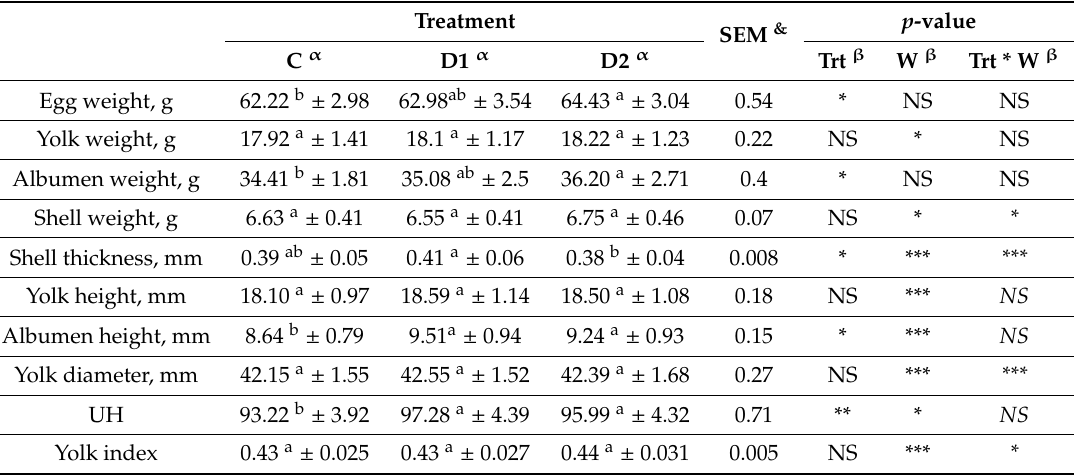
Table 3. E ff ect of spirulina on egg physical